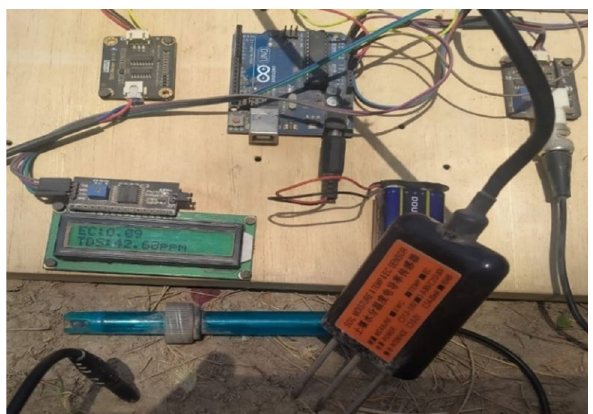
Fig. 5 Sensor node porotype with sampling in the field